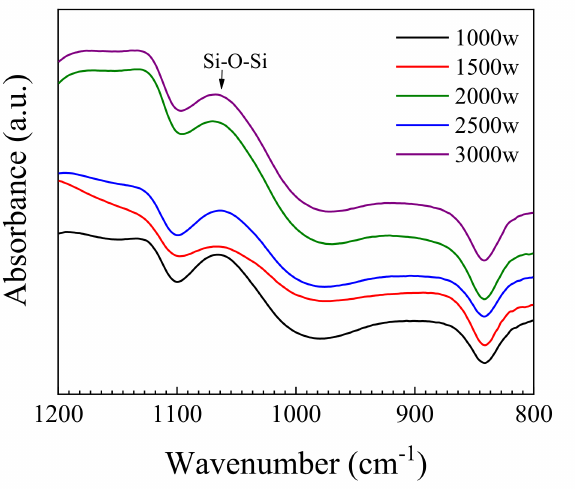
Figure 8. FTIR spectra of the RP-ALD SiO 2 films with various plasma